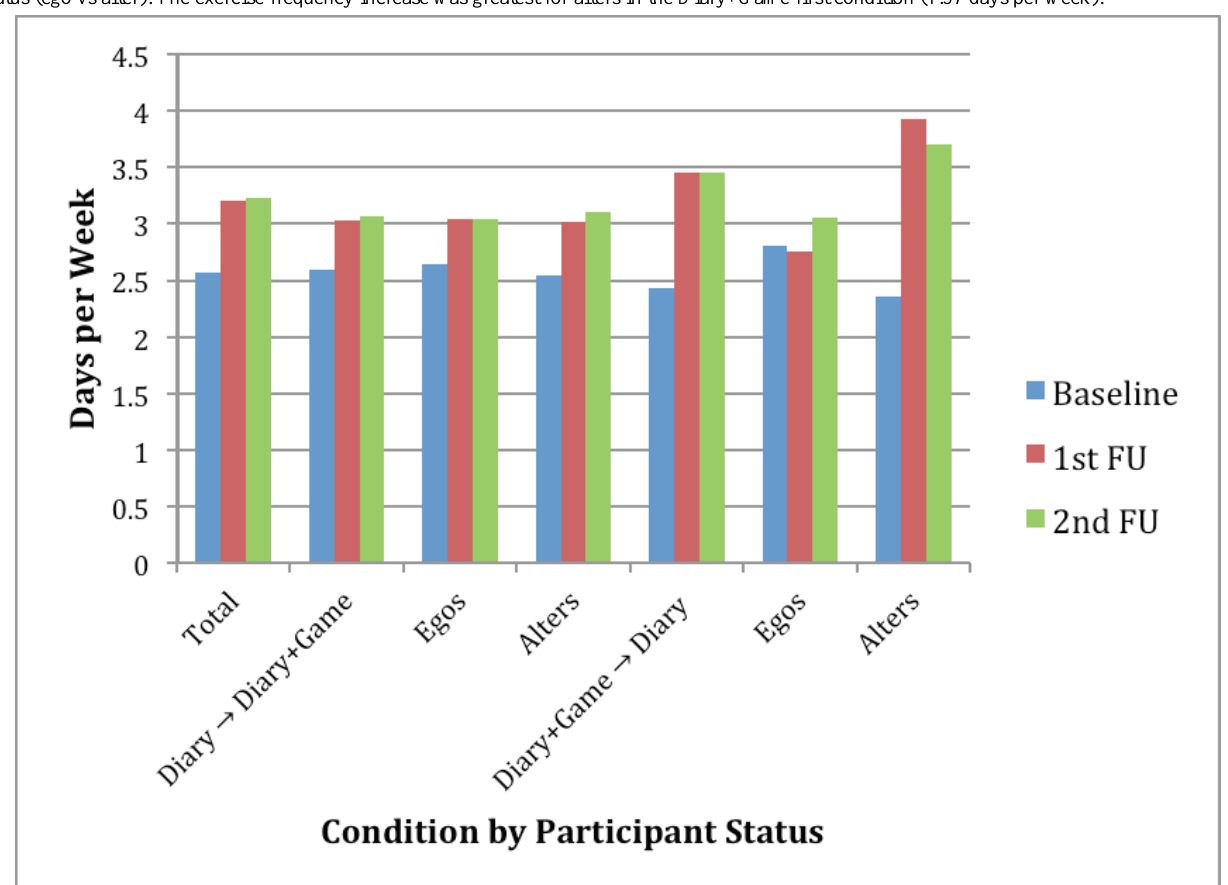
Figure 4. Exercise days per week at baseline, first, and second FU overall (total), by study condition (Diary first vs Diary+Game first), and by